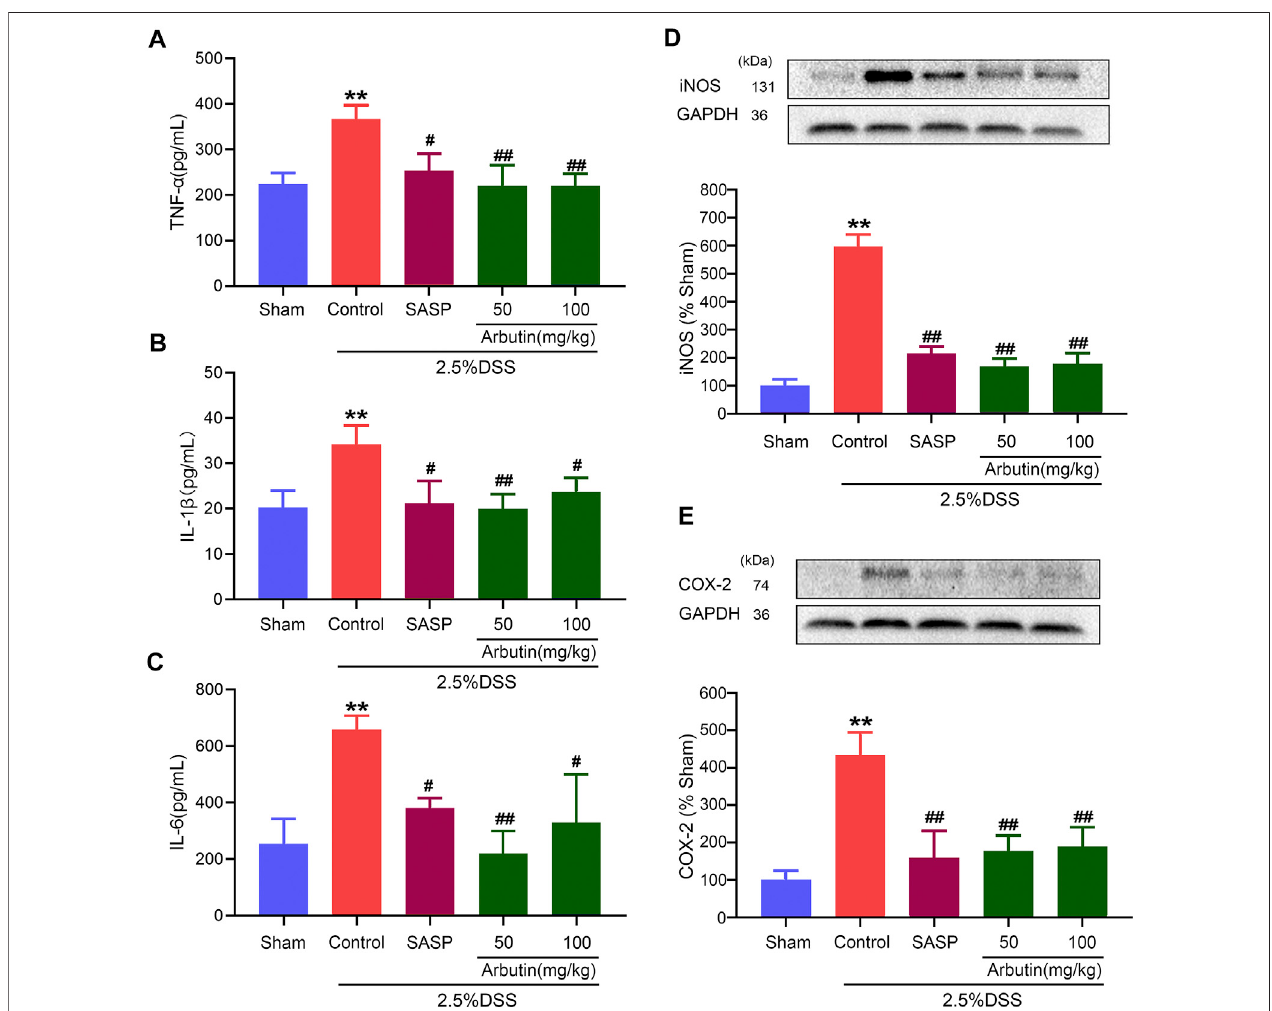
FIGURE 3 | Effects of arbutin on in fl ammation in colitis. As described in the Materials and Methods , blood from mice was centrifugated and were assayed for the determinationofthelevelsofTNF- α (A) ,IL-1 β (B), andIL-6 (C) ,andcolonsegmentsfrommicewereharvestedandwereusedtodeterminetheexpressionlevelsofiNOS (D) and COX2 (E) . Data were expressed as mean ± SD. ** p < 0.01 compared with sham operation group; # p < 0.05 compared with DSS induced colitis group; ## p < 0.01 compared with DSS induced colitis group; n (cid:1) 3 samples for Western blot experiments; n (cid:1) 6 samples for other